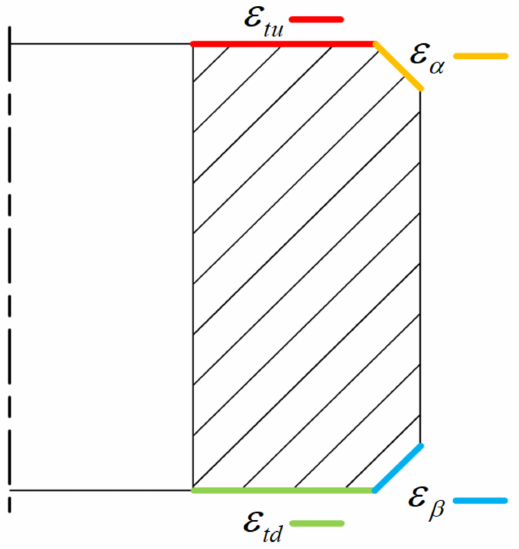
Figure 5. Schematics of equivalent strain